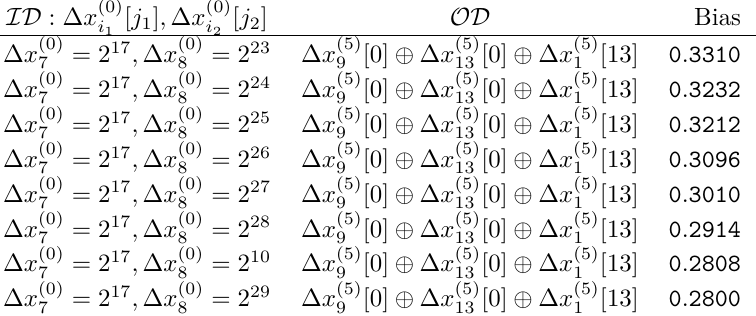
Table 6: Best second order triple bit differentials for 5 rounds of